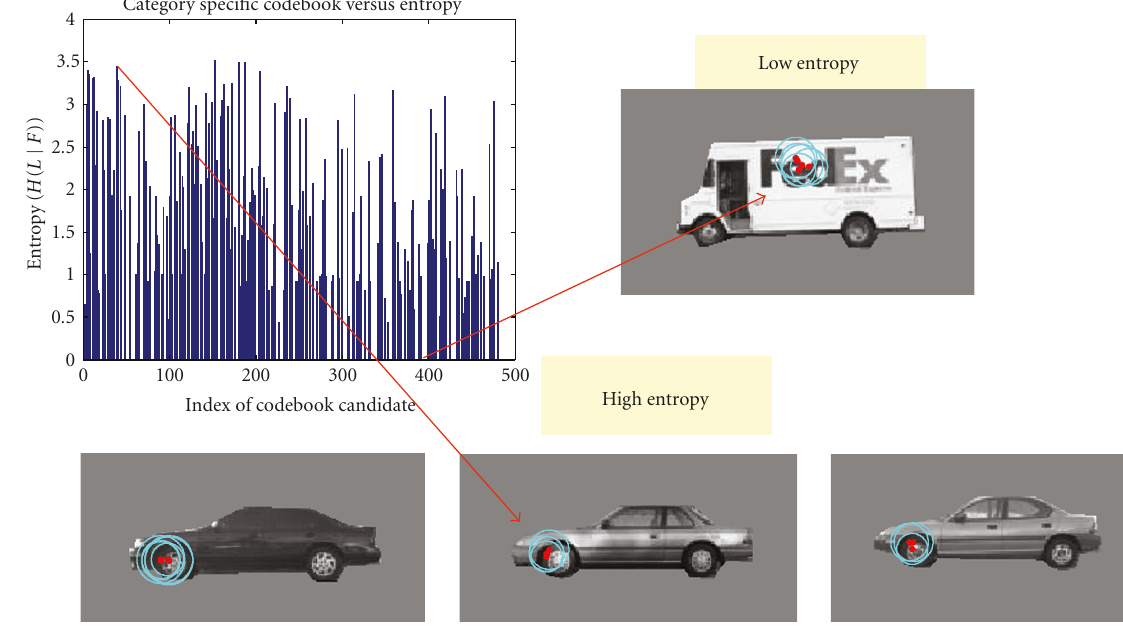
Figure 16: Entropy of candidate codebook and corresponding visual features.